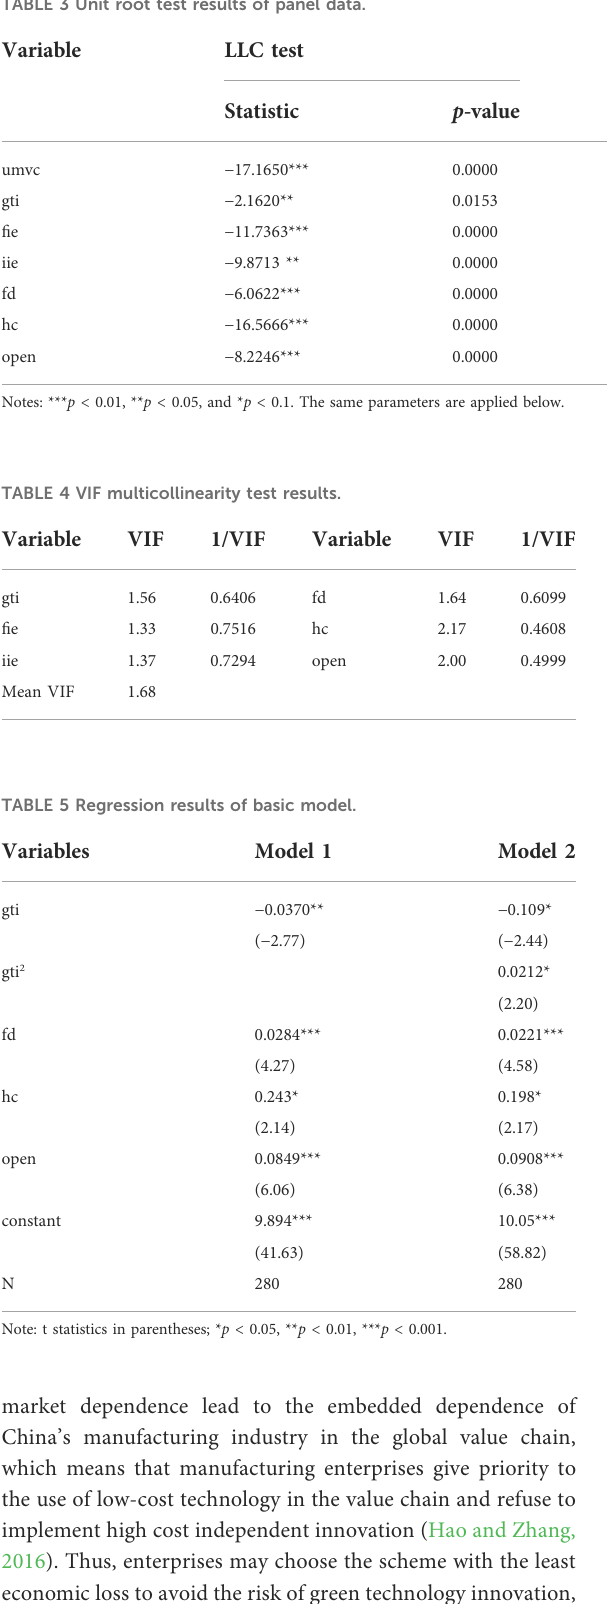
TABLE 3 Unit root test results of panel data.